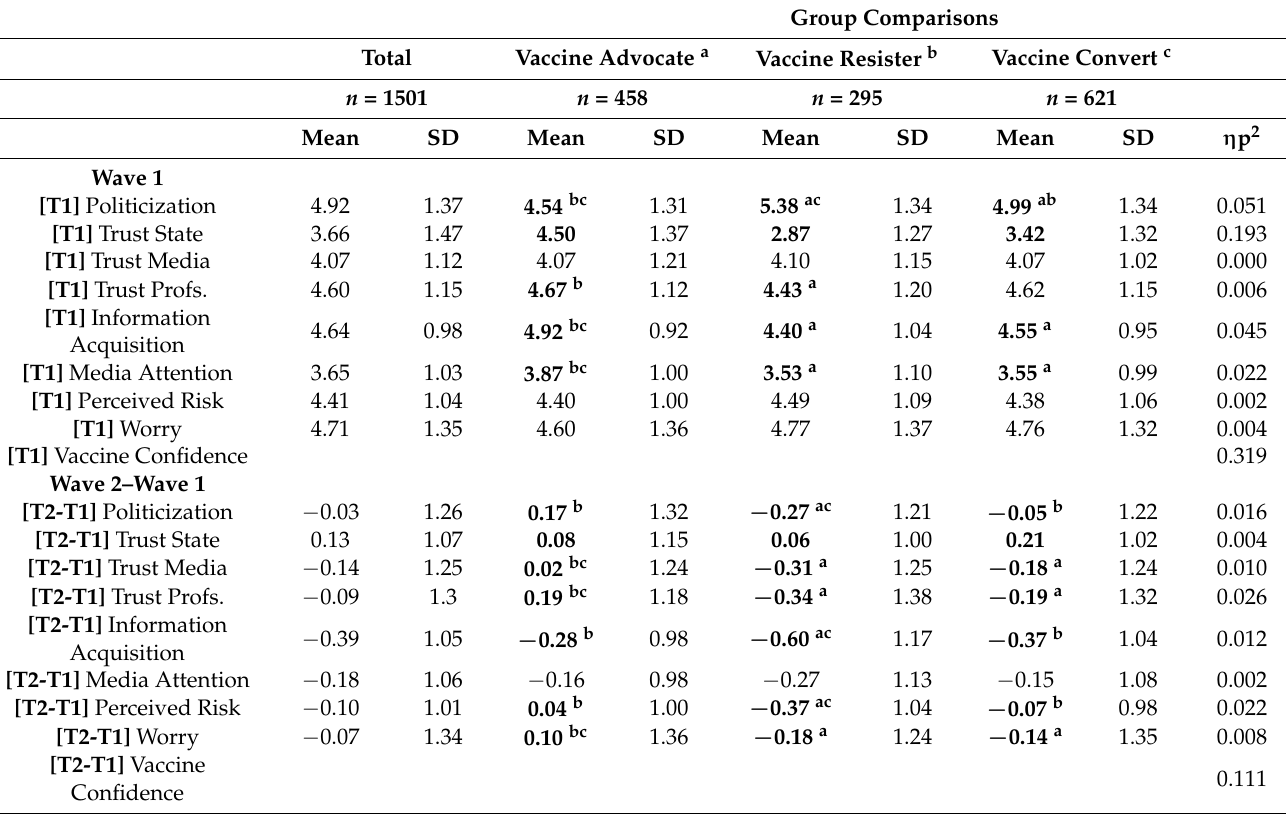
Table 3. Psychological indicators of vaccine advocates, resisters, and converts. Group Comparisons Total Vaccine Advocate a Vaccine Resister b Vaccine Convert